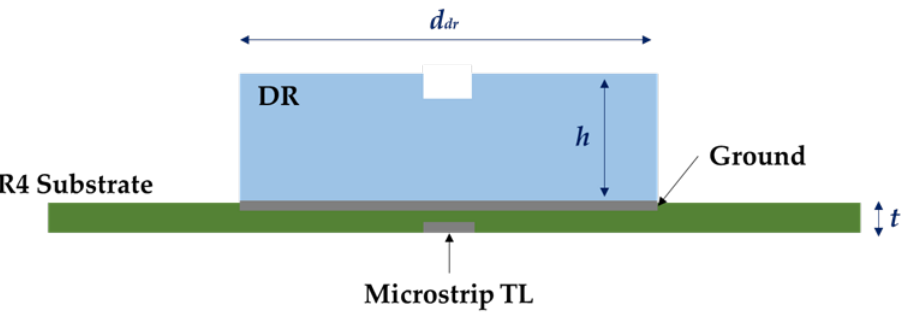
Figure 2. DR sensor scheme showing the sensor placement on the ground to achieve the coupling between the DR and the Microstrip TL.